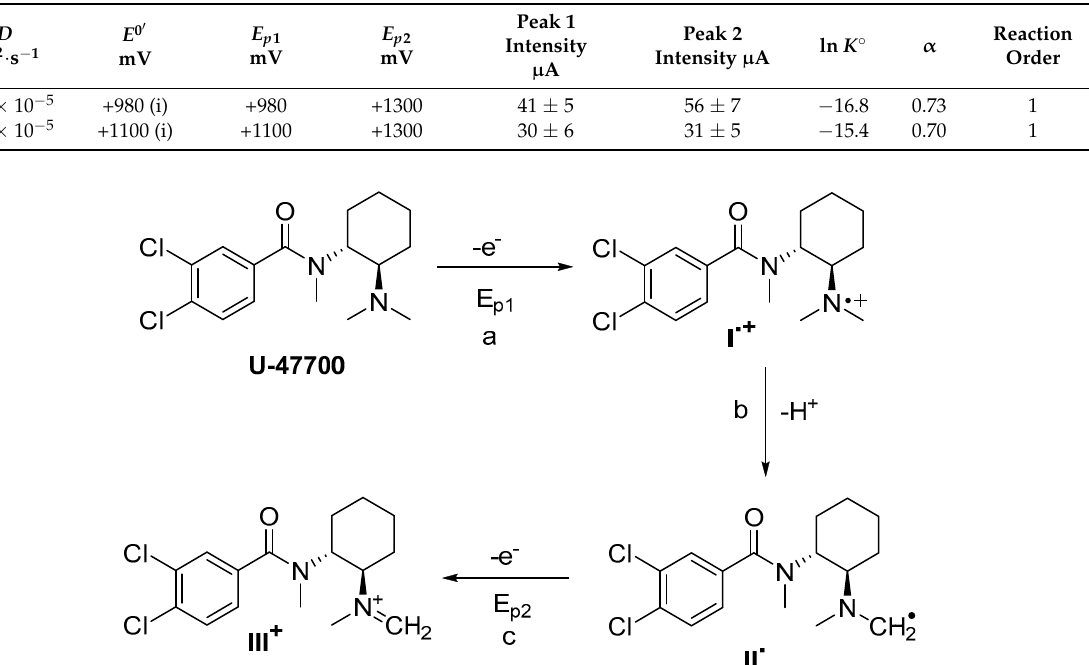
Table 2. Peak potential and electrochemical behavior of the studied compounds evaluated by CV (2.5 in ethanol, containing 0.1 M lithium perchlorate and 0.10 M 2,6-lutidine, measured at scan speed 50 mV · s − 1 ). Note: i = irreversible. D = diffusion coefficient. K ◦ and α refer to the process described by E p1 (path a in Scheme 3).